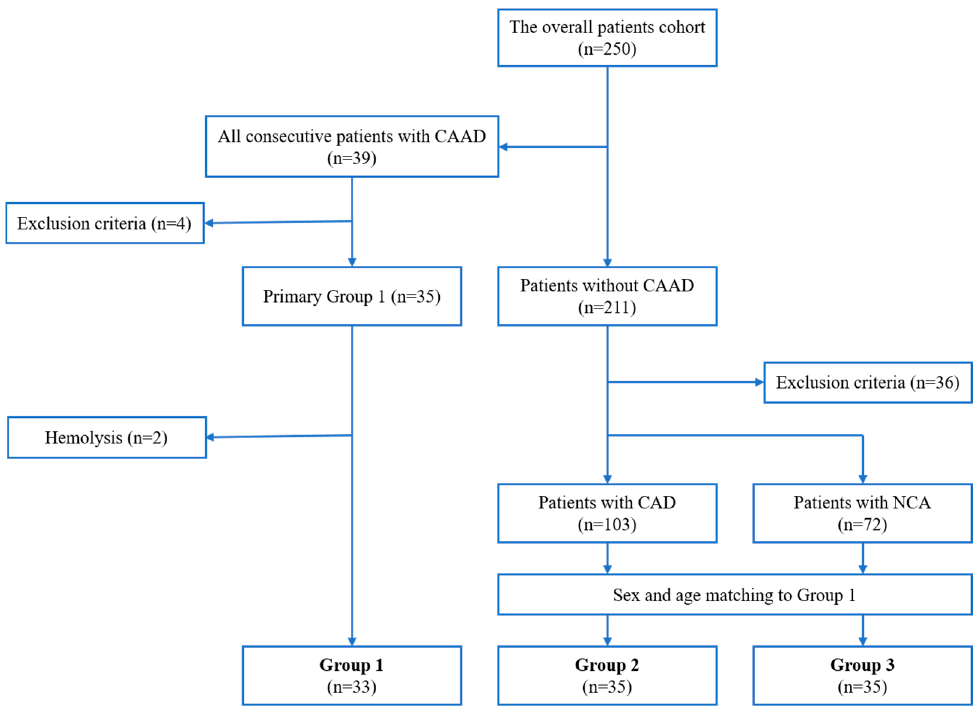
Figure 3. Flowchart of the study population. CAAD, coronary artery aneurysmal disease; CAD, coronary artery disease; NCA, normal coronary arteries.